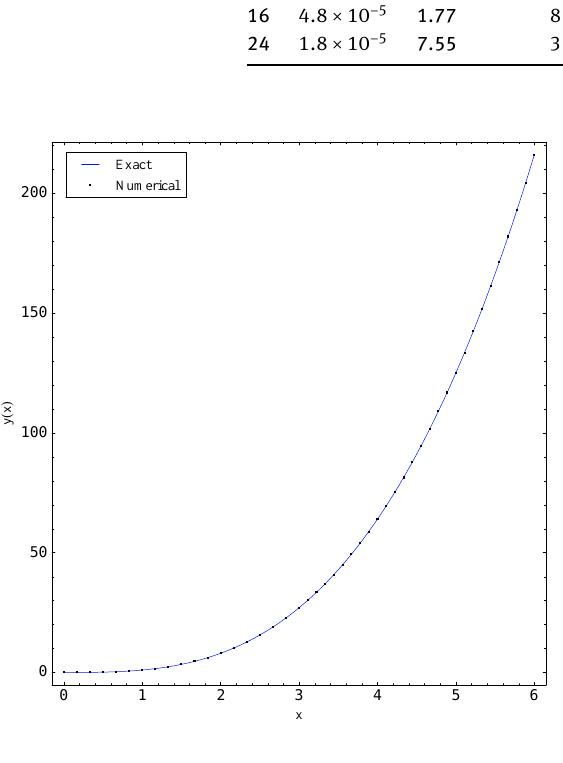
Fig. 8: Comparison of y ( x ) with h = 1 , N = 30 for α = 2.7, β = 0.7, γ = 1.7 for Example 4.